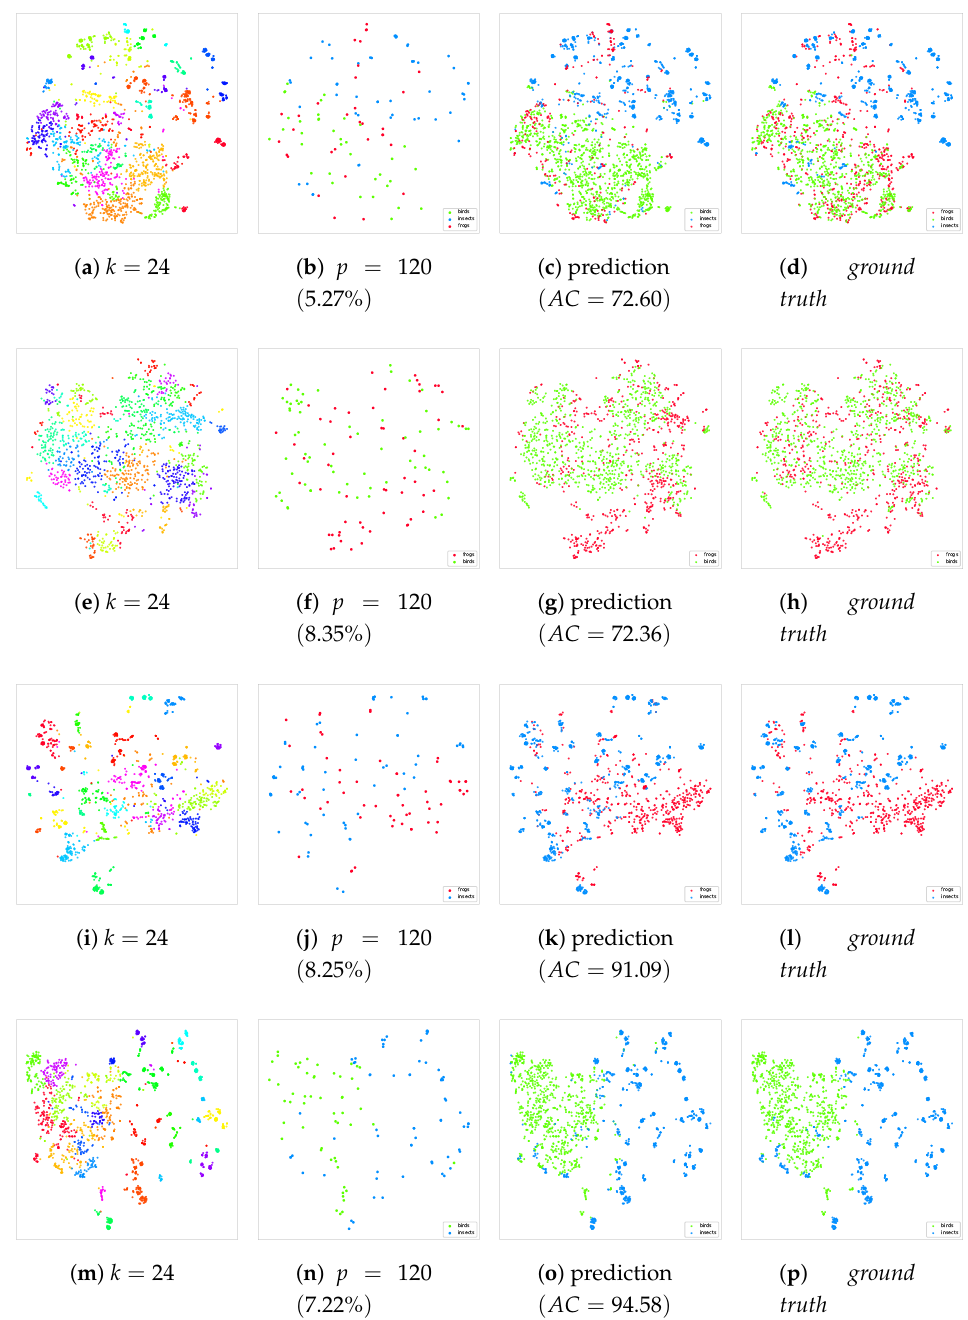
Figure 5. Sample visualizations of label predictions: the lines from top to bottom show the t-SNE projections of datasets DS1, DS2, DS3, and DS4 with their best features. Along the columns from left to right, colors represent each of the steps of the method: Clustering ; Sampling and Annotation ; and Learning-Prediction , as well as the Ground-truth